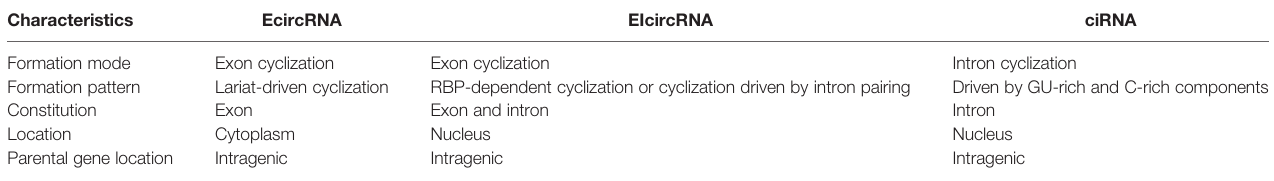
TABLE 1 | Similarities and differences among the three types of